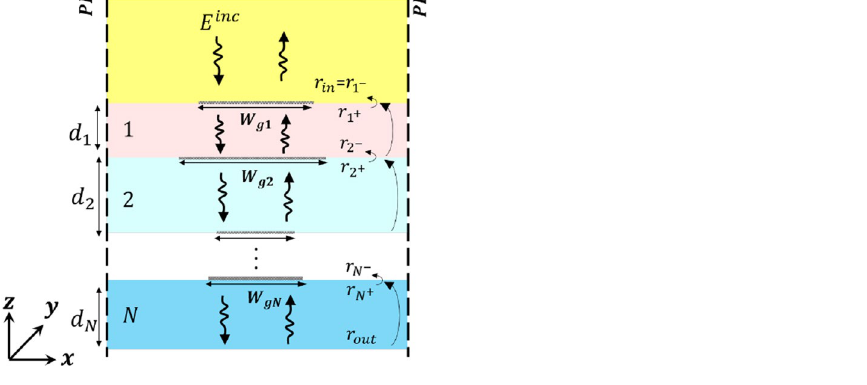
Figure 6. Reflection coefficient transformation through multilayer PAMGS. Generally, the graphene width in each layer can be